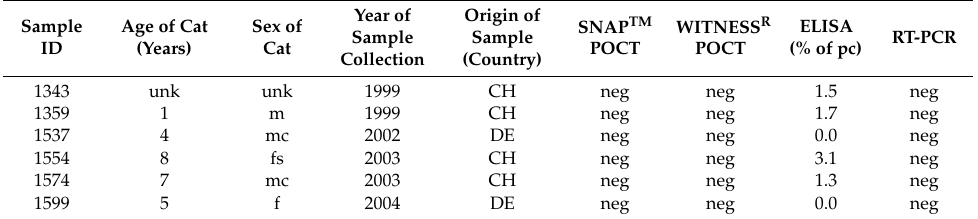
Table 4. Characteristics of the 70 false ELISA-negative samples (FIV WB-positive and FIV-TM